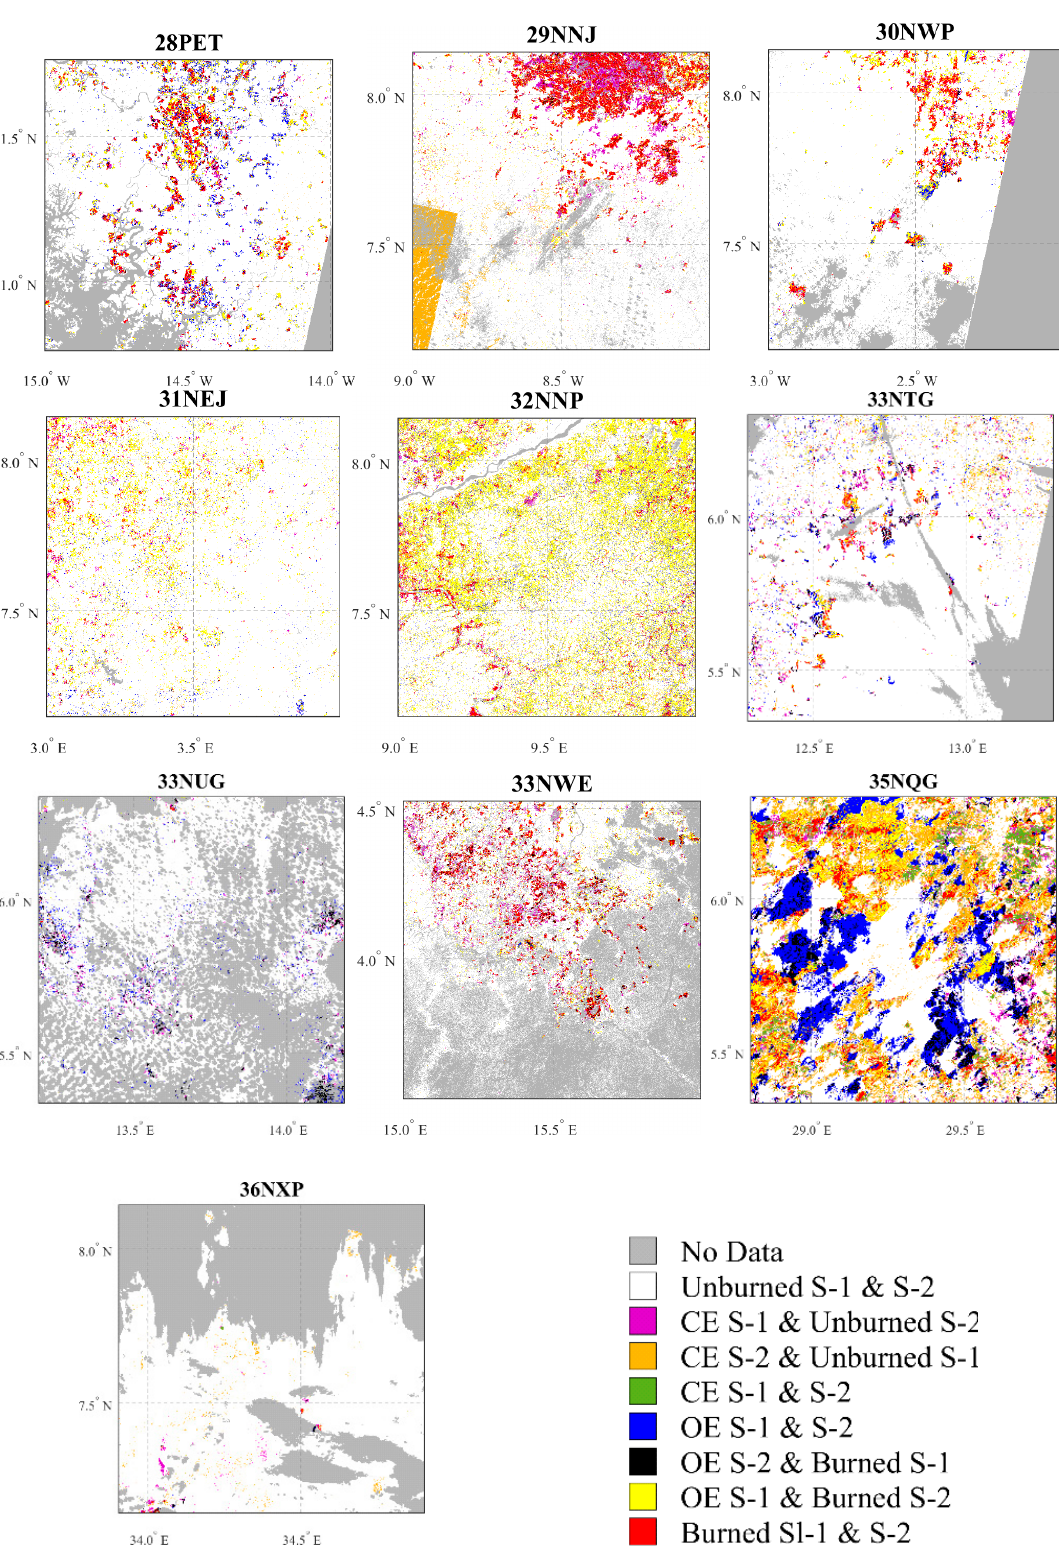
Figure 2. Pixel-wise agreement between reference and burned areas detected by the Sentinel-2 (i.e., Ots) and Sentinel-1 (i.e., RtsB) algorithms.